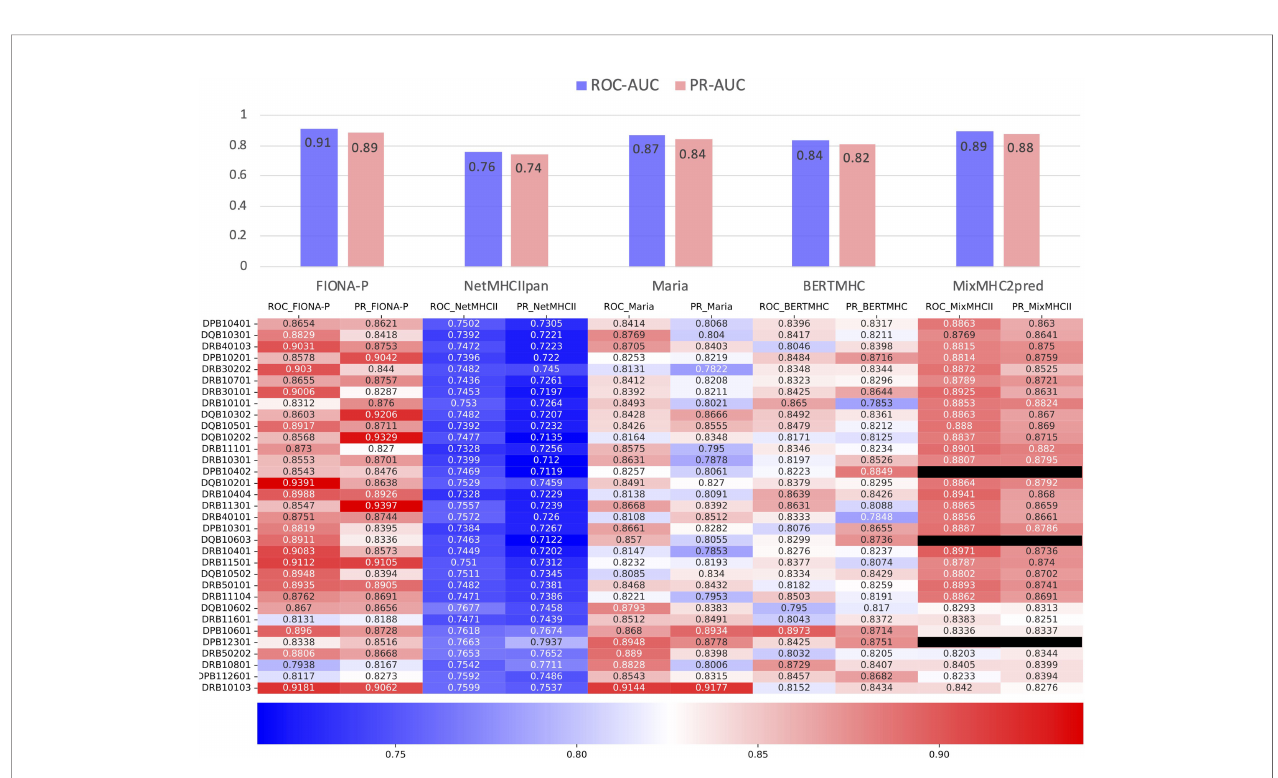
FIGURE 6 | Comparison of FIONA-P and other prediction tools on the presentation data of all available MHC-II subtypes. The black ones indicate that those MHC-II subtypes are not supported.